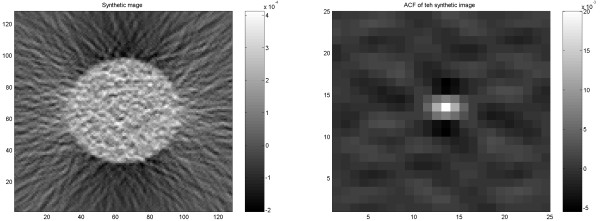
Example of synthetic image with additional Poisson noise with an angular dependent magnitude (left) and the result of applying ACF on the images (right).